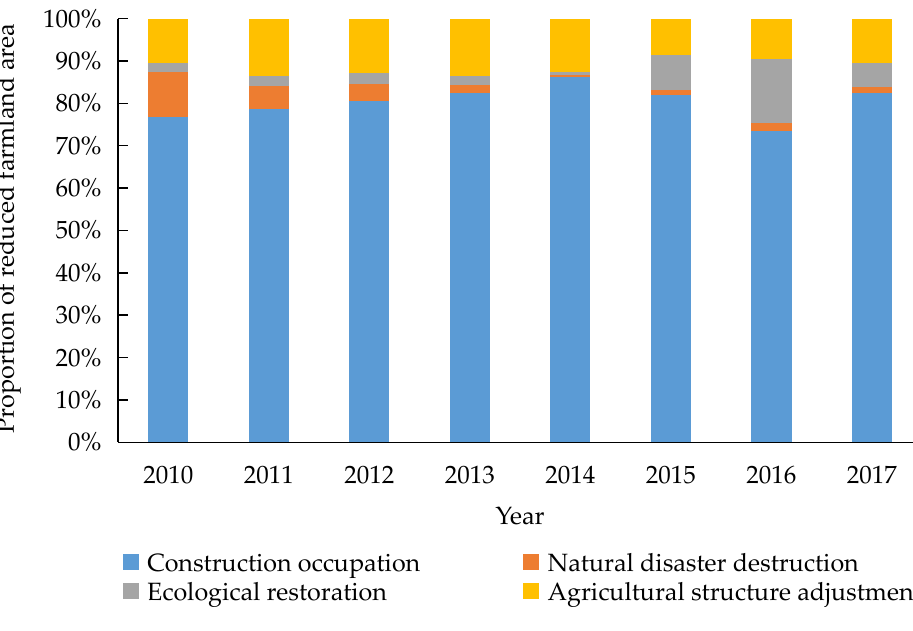
Figure 7. Changes in China’s farmland reduction from 2010 to 2017 [66].